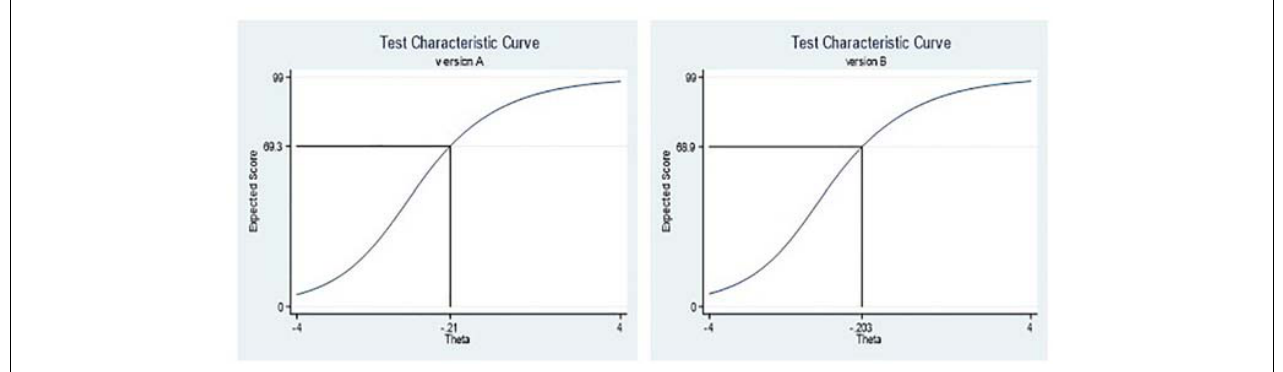
FIGURE 4 | Test characteristic curves for m = 69.25 in version A and for m = 68.87 in version